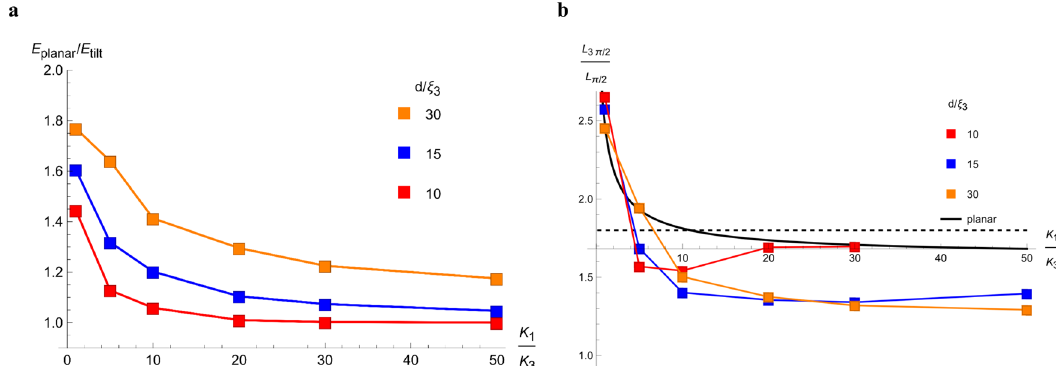
Fig. 9 Characteristics of simulated DW pairs. a Energy ratio of a planar domain wall ( θ = 0) versus one with a tilt ( θ > 0), as calculated from minimizing the Frank – Oseen energy in Eq. (4) using the ansatz in Eq. (3) for various values of K 1 / K 3 and d / ξ 3 . Note the marked energy gain from introducing a tilt for thick cells. For thinner cells, d = ξ 3 < 10, the gain is negligible, especially at large ratios K 1 = K 3 . b Ratio of width parameters L 3 π = 2 = L π = 2 vs K 1 = K 3 for different cell thicknesses d = ξ 3 . Note that this ratio is expected to be smaller whenever there is substantial tilt in the director con fi guration. For thinner cells, d = ξ 3 < 10, the = K = K ¼ 0 : 5. The dashed line ratio approaches the planar value (black line) for large K as the tilt becomes negligible. In all simulations, ω ¼ 0 : 1 and K 1 3 2 3 shows L 3 π = 2 = L π = 2 = 1.8 obtained by averaging experimental data for 64 DW pairs. The lines connecting the data points in these plots are a guide to the